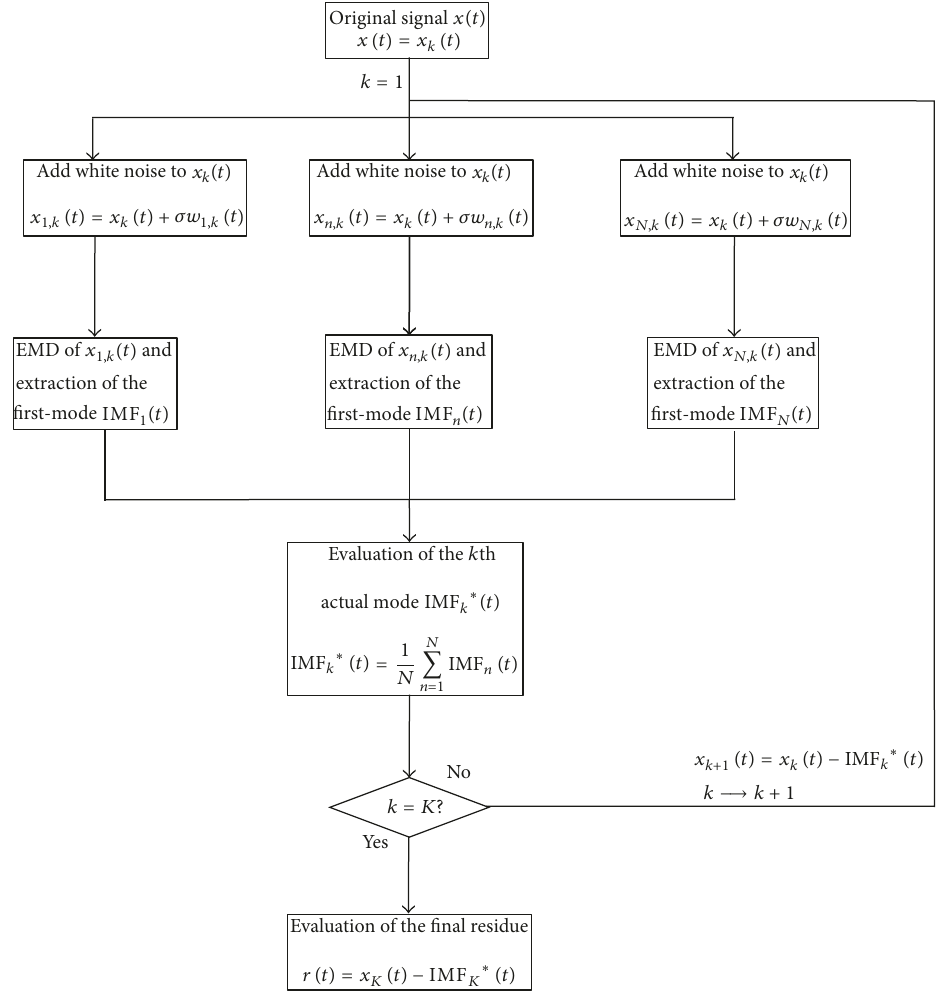
Figure 3: Flow-chart of the CEEMDAN algorithm.